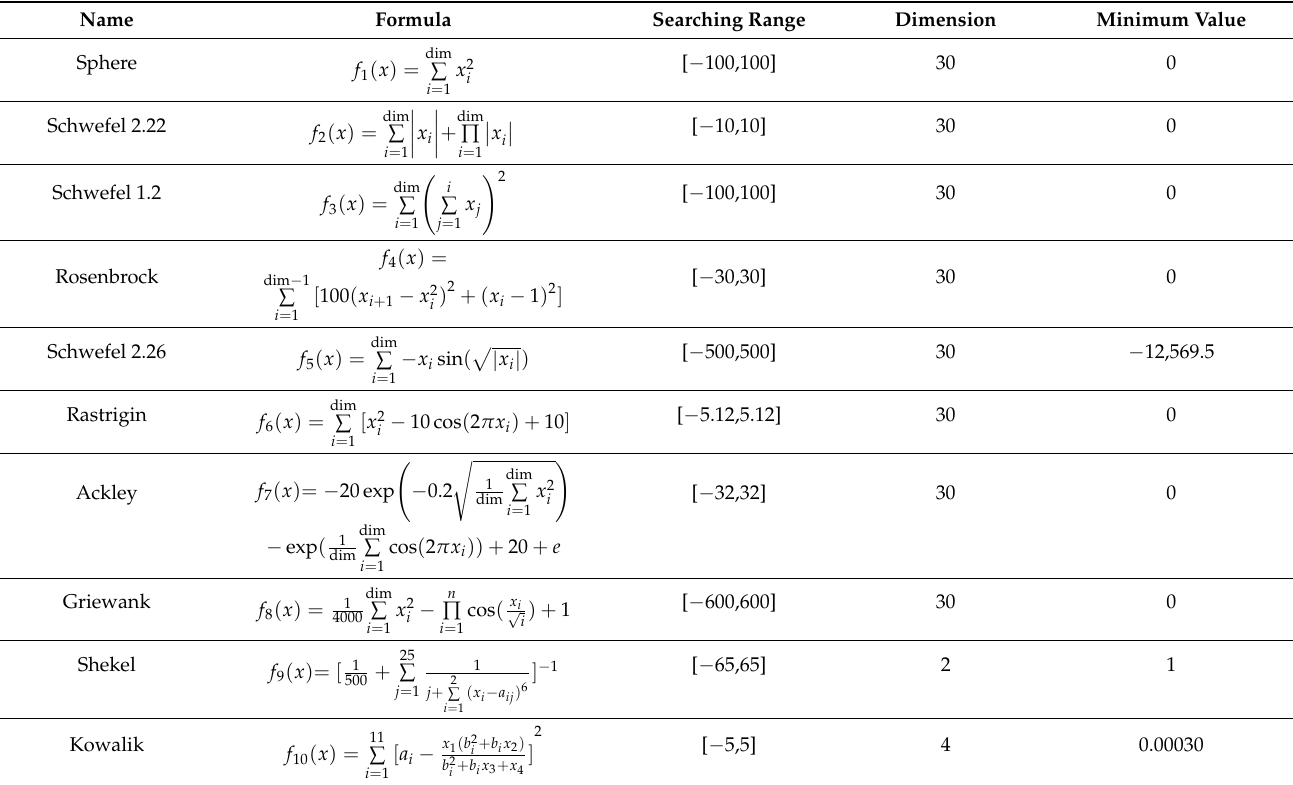
Table A1. The benchmark functions of